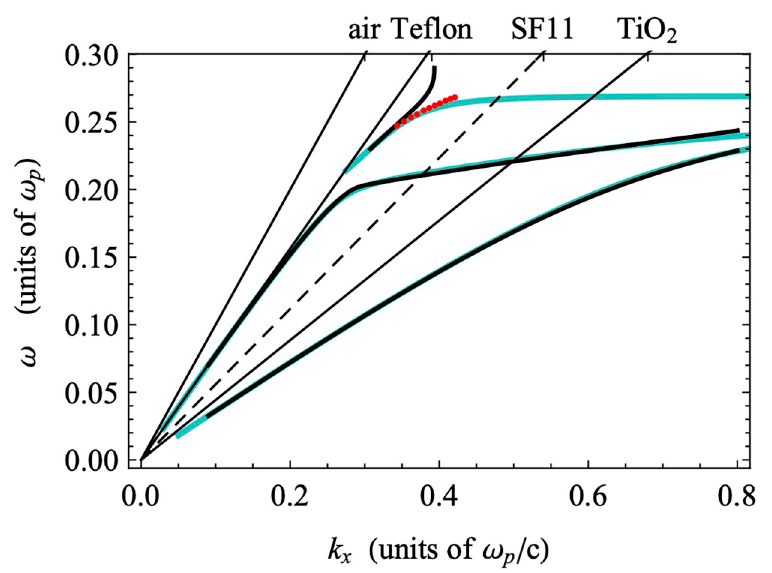
Fig 6. Calculated dispersions generated both with (black lines) and without (blue lines) damping included in the gold dielectric function. Shown are the light lines for the relevant dielectric materials and the minima (red dots) of the measured ATR curves (see Fig